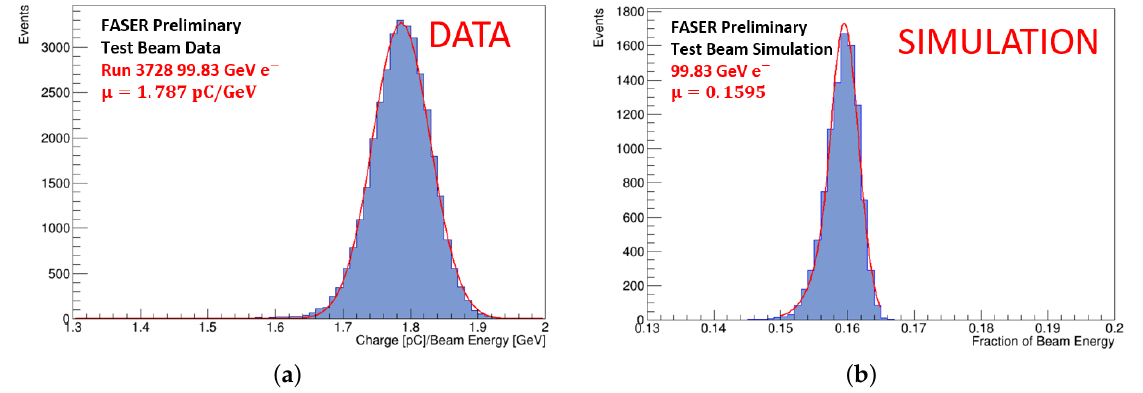
Figure 13. ( a ) Deposited charge in the calorimeter for a 100 GeV test beam electron. ( b ) Deposited energy in the calorimeter for a simulated 100 GeV electron.